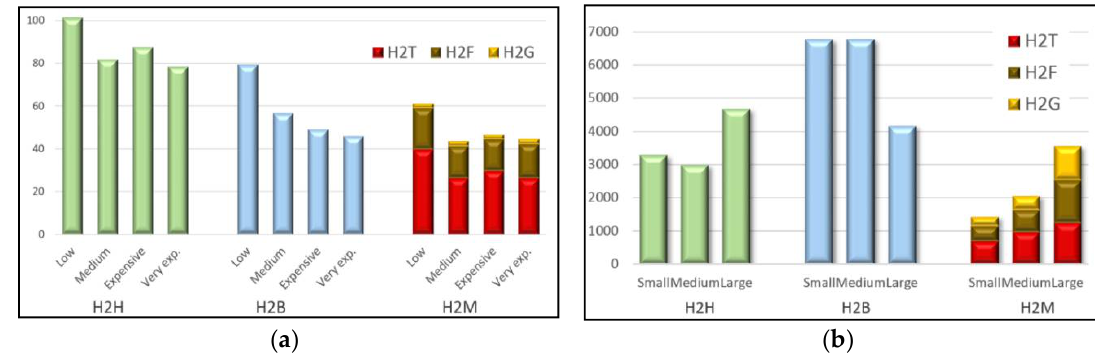
Figure 4. MANCOVA estimated marginal means of communication type per user per day, with six covariates for fixed factor ( a ) price of device for intensity; and ( b ) screen size for extensity.